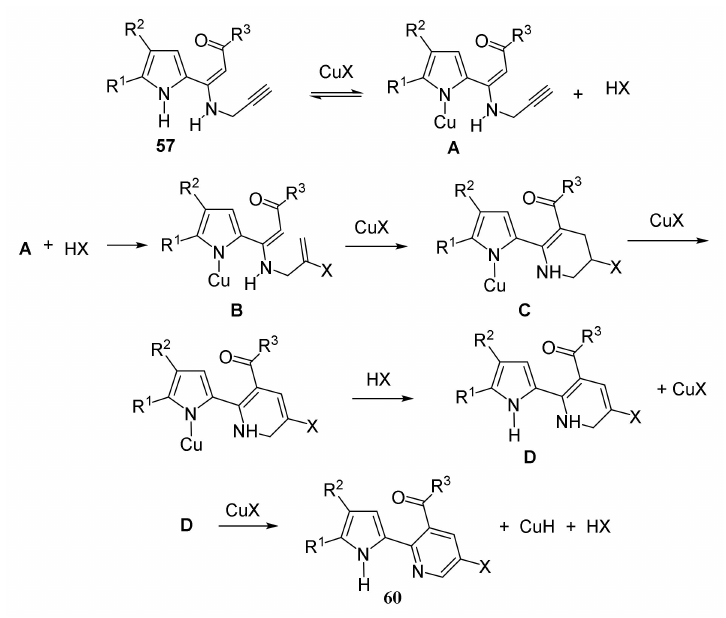
Scheme 34. Proposed scheme of halopyridines 60